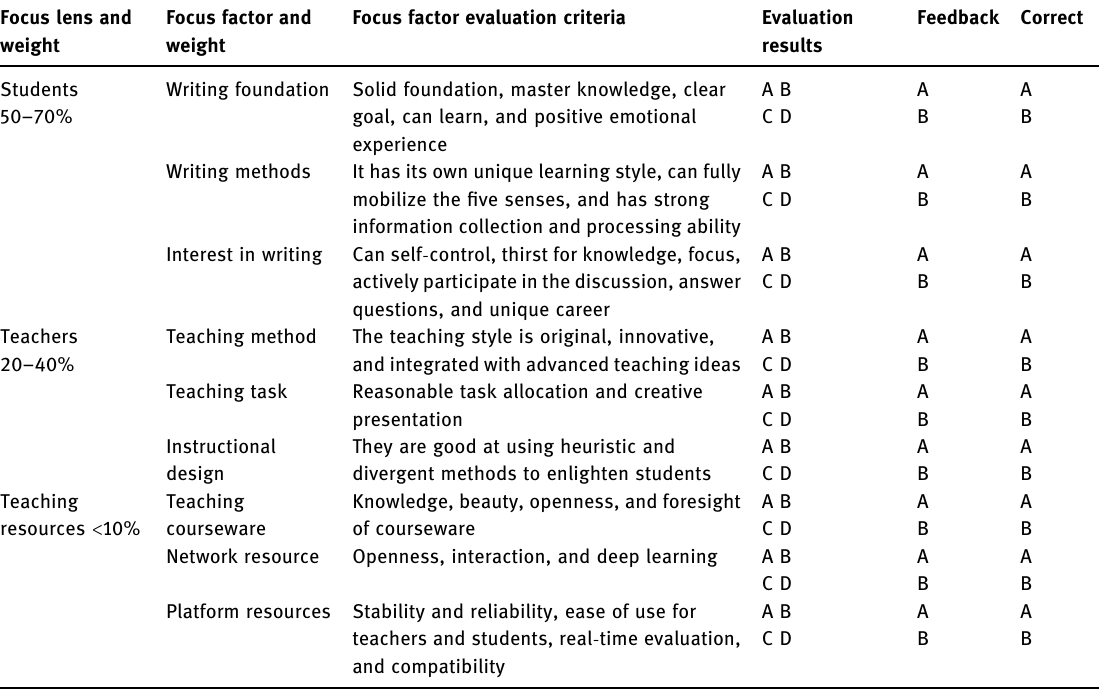
Table 1: Index system of dynamic evaluation model for English writing Focus lens